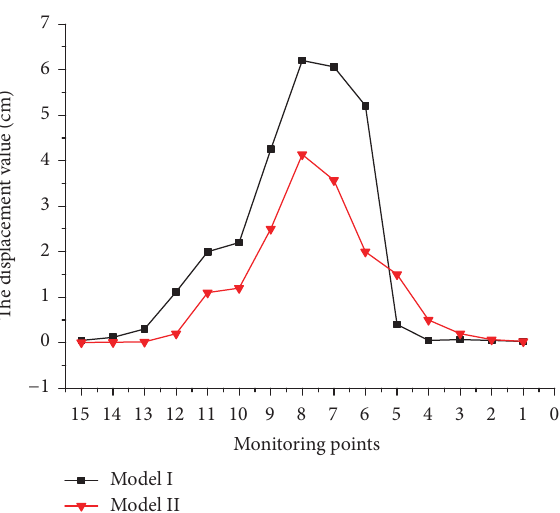
Figure 20: Displacement at each monitoring point.